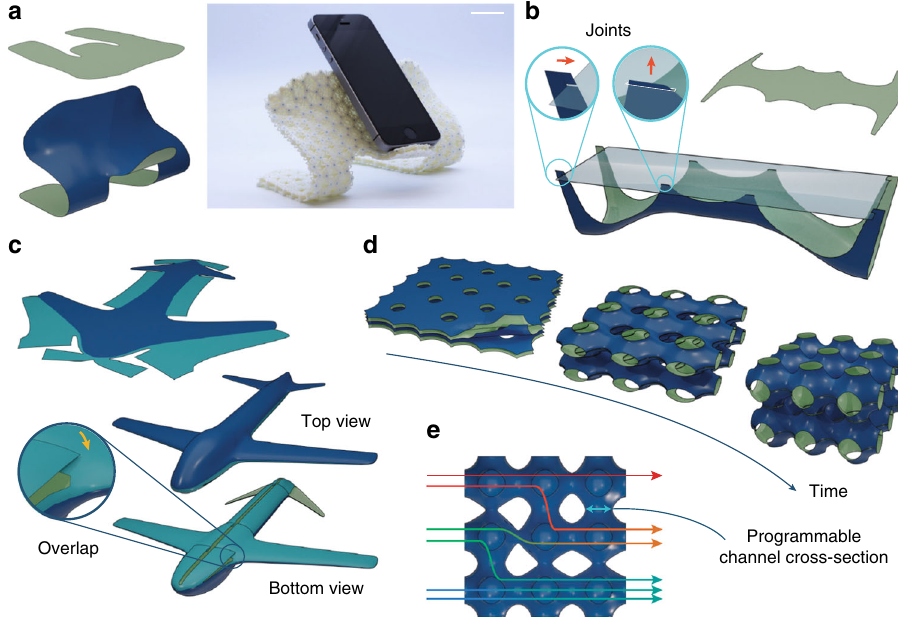
Fig. 4 Future concepts for spatio-temporally programmed materials. Potential applications for shells with programmable self-morphing, showing initial fl at and fi nal states. Opposite sides of each sheet are colored blue and green. a The load-bearing capability of our morphing shells is shown by a mobile phone stand. Scale bar, 3 cm. b Self-morphing can be applied to industrial design, for example to build aesthetically curved furniture with sequentially interlocking joints. c The outer shell of a self-morphing drone can be fabricated from a single sheet. The smooth aerodynamic shape is achieved with temporal programming of sequentially overlapping parts. d Stacked multilayer sheets can be used to create stiff, yet lightweight periodic mesostructures with temporally programmed porosity. Four sheet layers (left) morph into a Schwarz P surface (right) which ef fi ciently distributes external stresses through the structure. e Similar structures with programmable channel cross-section between the periodic blocks can be used to adjust fl ow rates through the